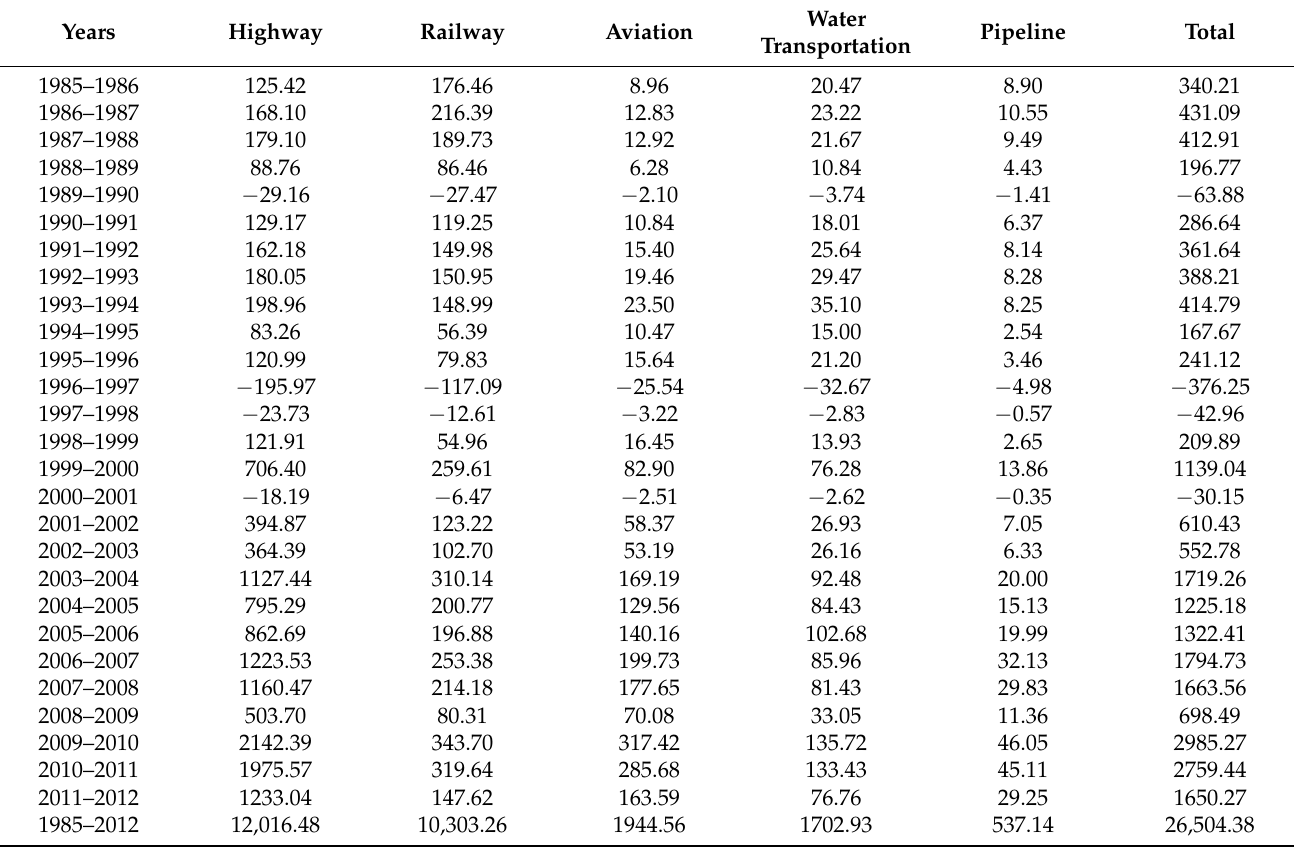
Table 3. The contribution of five transportation modes for irallic